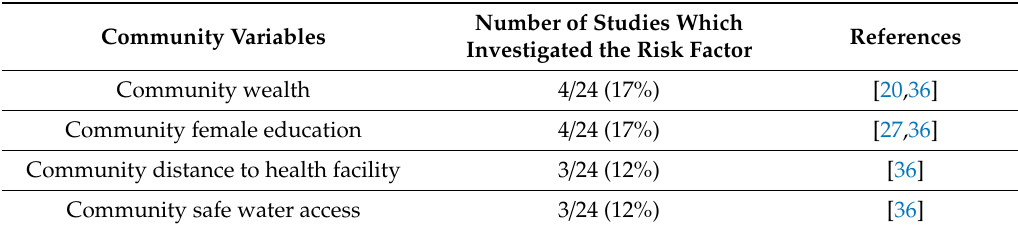
Table 8. Distribution of the study characteristics by community-related